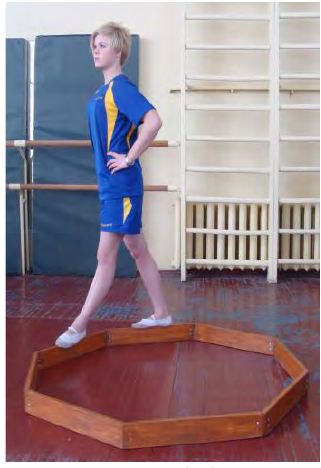
Fig.9. Dynamic balance test.